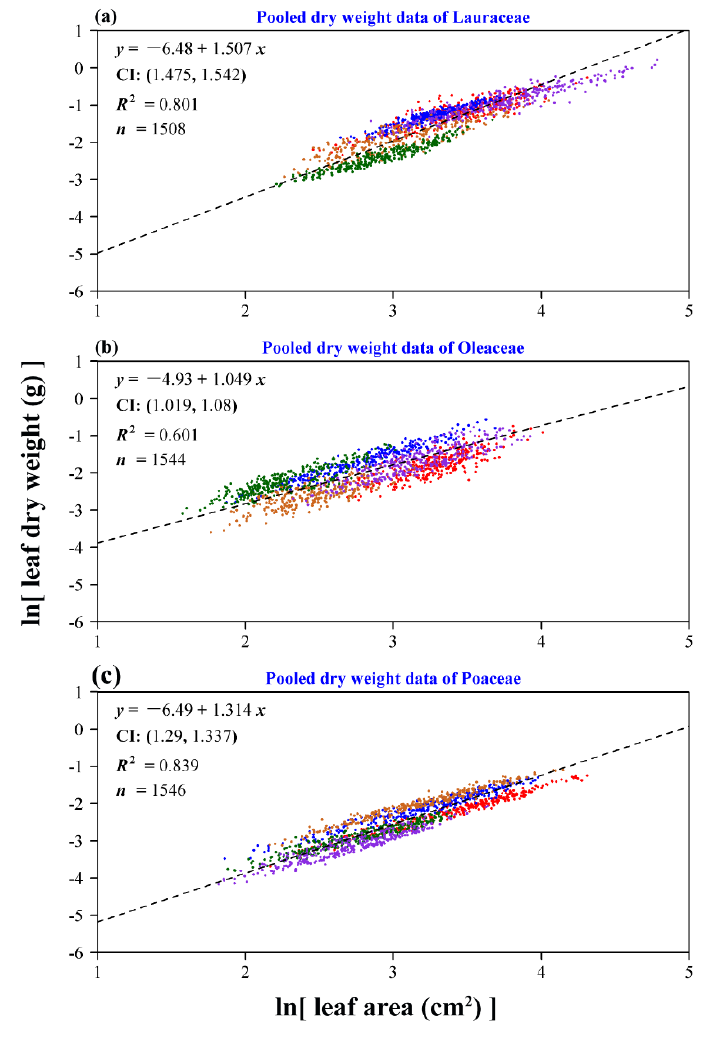
Figure 8. Scaling relationship of leaf dry weight to leaf area for the pooled data of every family: ( a ) Lauraceae; ( b ) Oleaceae; ( c ) Poaceae. In each panel, the colored points represent the observations, and the black dashed line represents the reduced major axis regression line. Furthermore, y represents the natural logarithm of leaf dry weight in g, x represents the natural logarithm of leaf area in cm 2 , CI represents the 95% confidence interval of the slope, R 2 is the coefficient of determination used to measure the goodness of fit, and n represents the total number of leaves sampled for the species of the same family. Different colored points represent different species in each panel, but the same colors in different panels do not represent the same species.